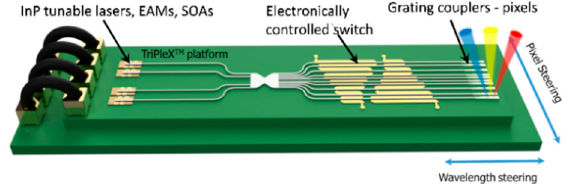
Figure 1. Conceptual illustration of the envisioned transmitter.